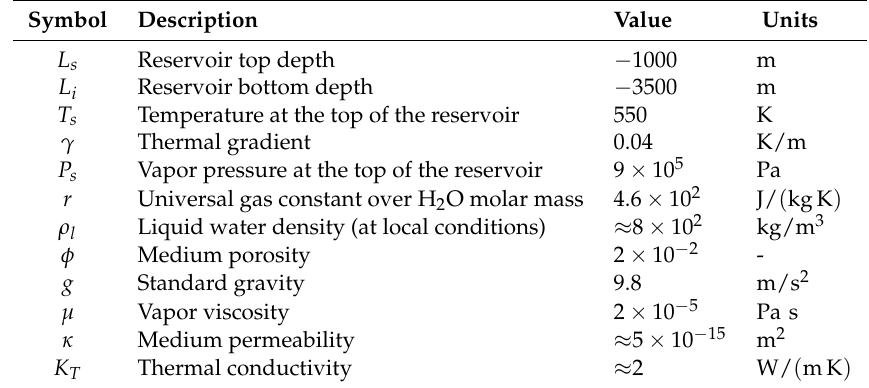
Table 1. List of parameters referring to the reservoir of Larderello [10,14]. All dimensionless constants used in the present work are evaluated by using these values. A full list of additional simbols is reported in Table